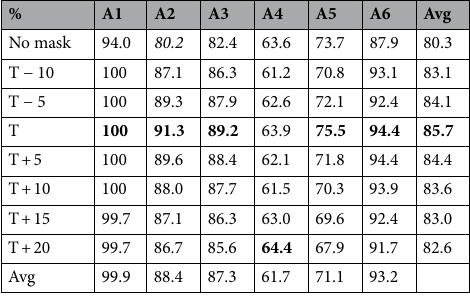
Table 8. Classification results for the spectrogram (‘No Mask’) and masked spectrogram data domains, with radar features and different threshold values.